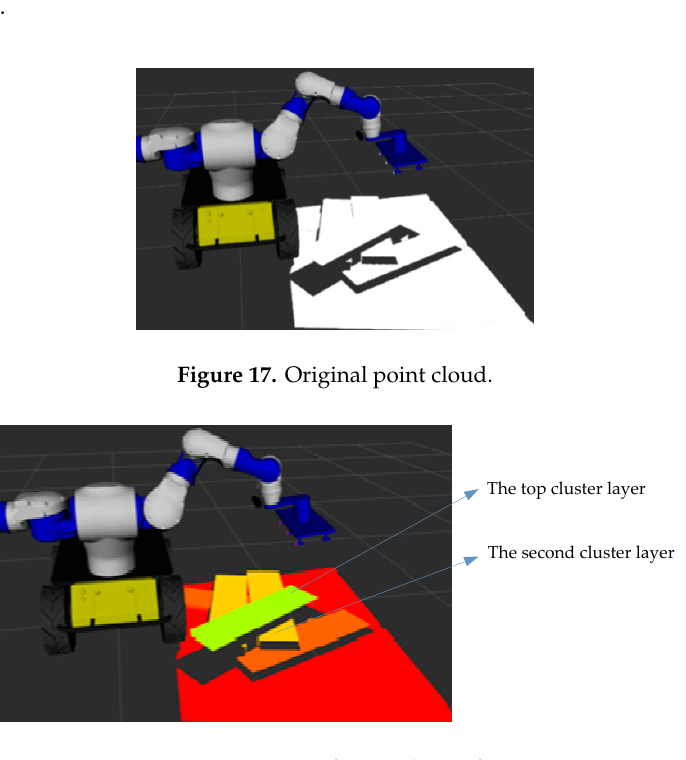
Figure 18. The segmentation result of point cloud after regional clustering.